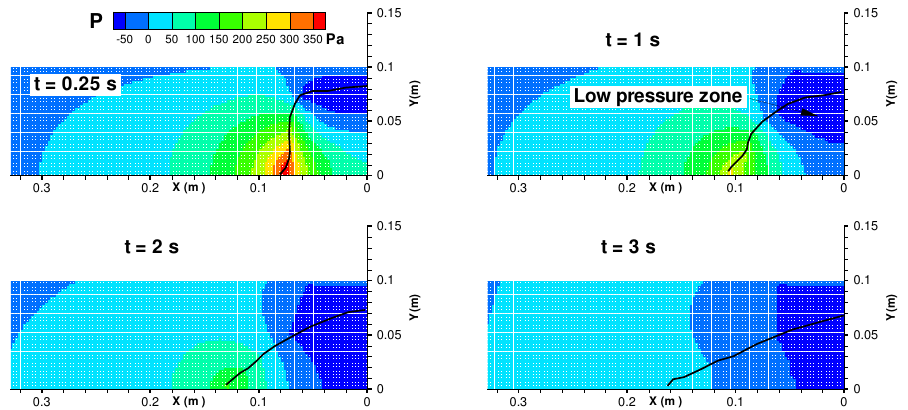
Figure 12. Numerical results show the relative pore water pressure field evolution during the collapse process of an initially dense packing submerged granular